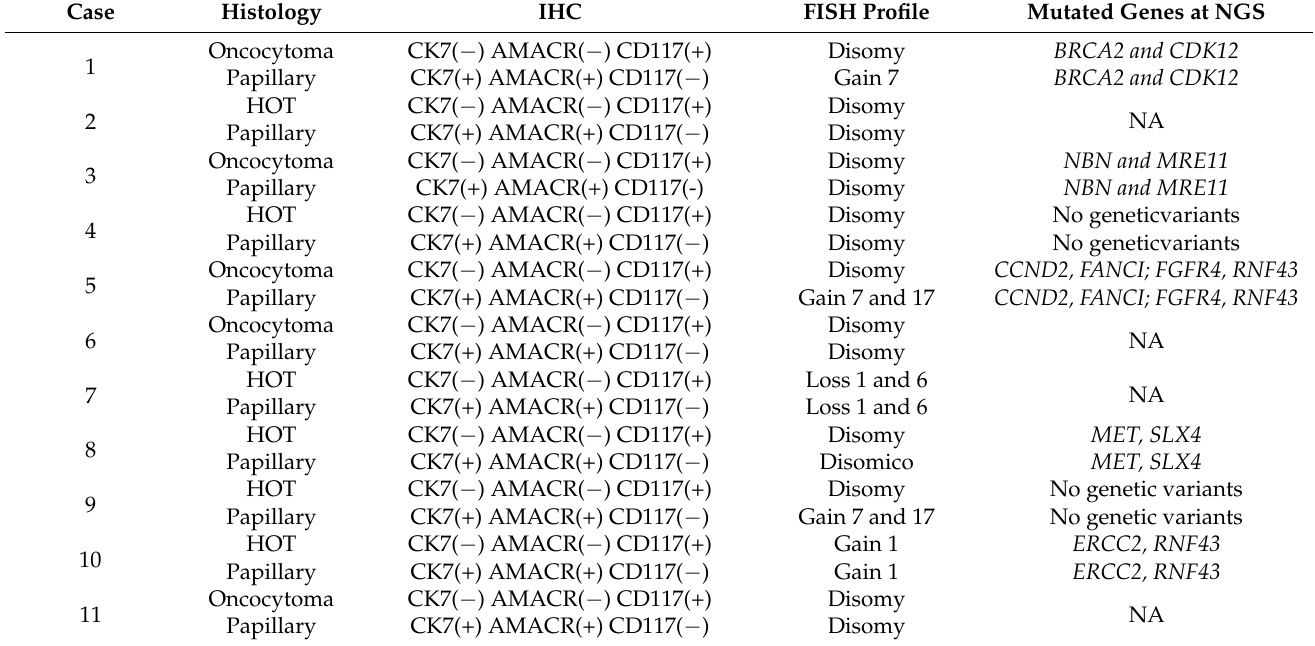
7, and 17 (Figure 1). Table 2. Histological, immunophenotypic, and genetic features of the 11 cases: IHC (immunohistochemistry), FISH (flu- orescent in situ hybridization), and HOT (hybrid oncocytic tumor).